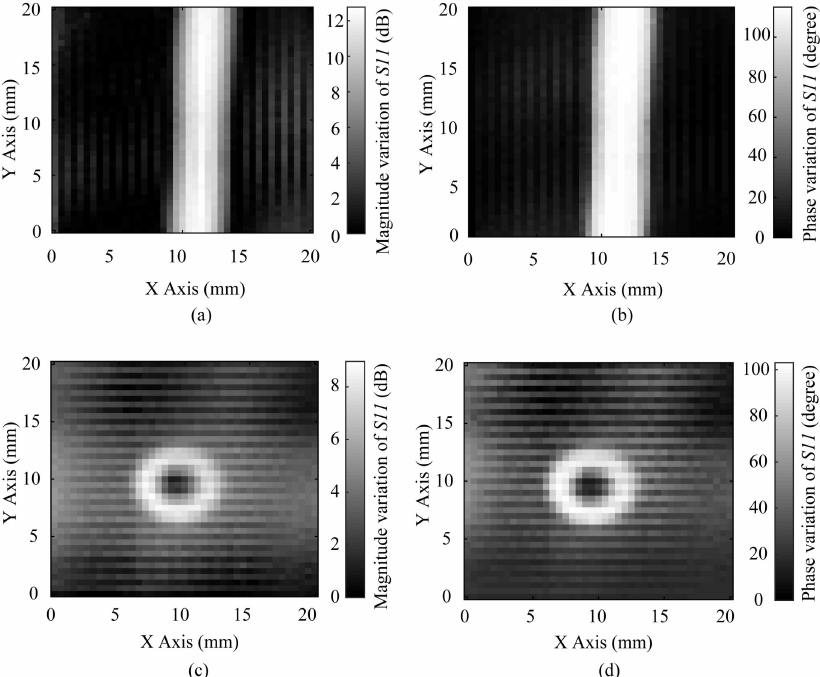
Figure 15. ( a ) The image of the 0.2 mm wide crack in the aluminum board obtained by the magnitude variation; ( b ) The image of the 0.2 mm wide crack obtained by the phase variation; ( c ) The image of the 1.5 mm diameter via obtained by the magnitude variation; ( d ) The image of the 1.5 mm diameter via obtained by the phase